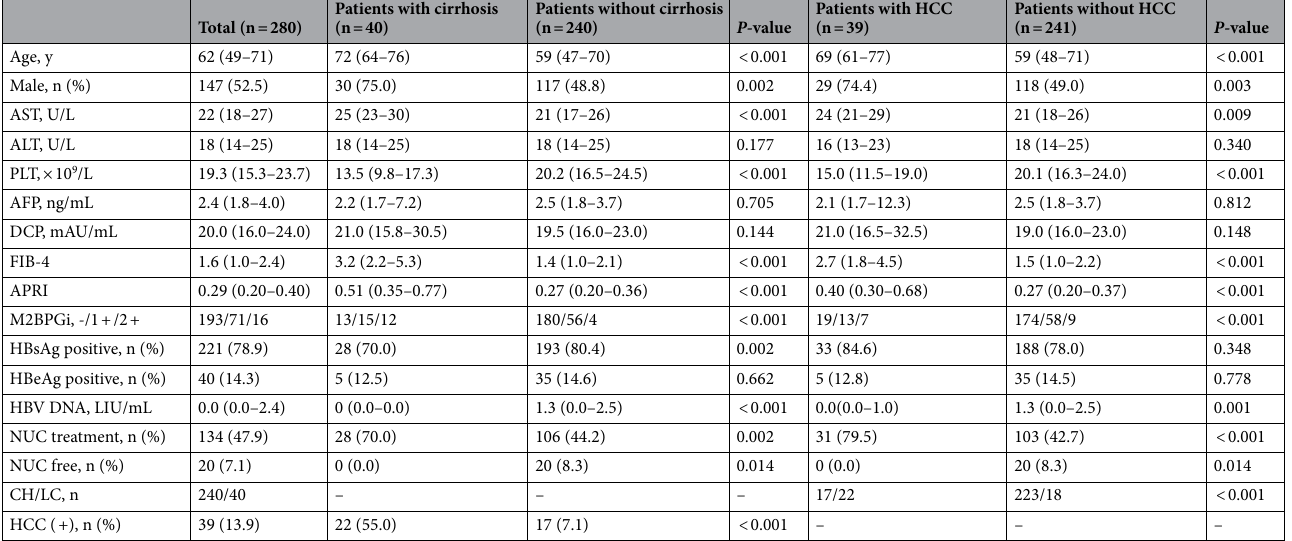
Table 1. Demographic and clinical characteristics of patients. HCC hepatocellular carcinoma, AST aspartate aminotransferase, ALT alanine aminotransferase, PLT platelet count, AFP α-fetoprotein, DCP des-γ-carboxy prothrombin, FIB-4 fibrosis index-4, APRI aspartate aminotransferase to platelet ratio index, M2BPGi MAC-2 binding protein glycosylation isomer, HBV hepatitis B virus, NUC nucleot(s)ide analogue, CH chronic hepatitis, LC liver